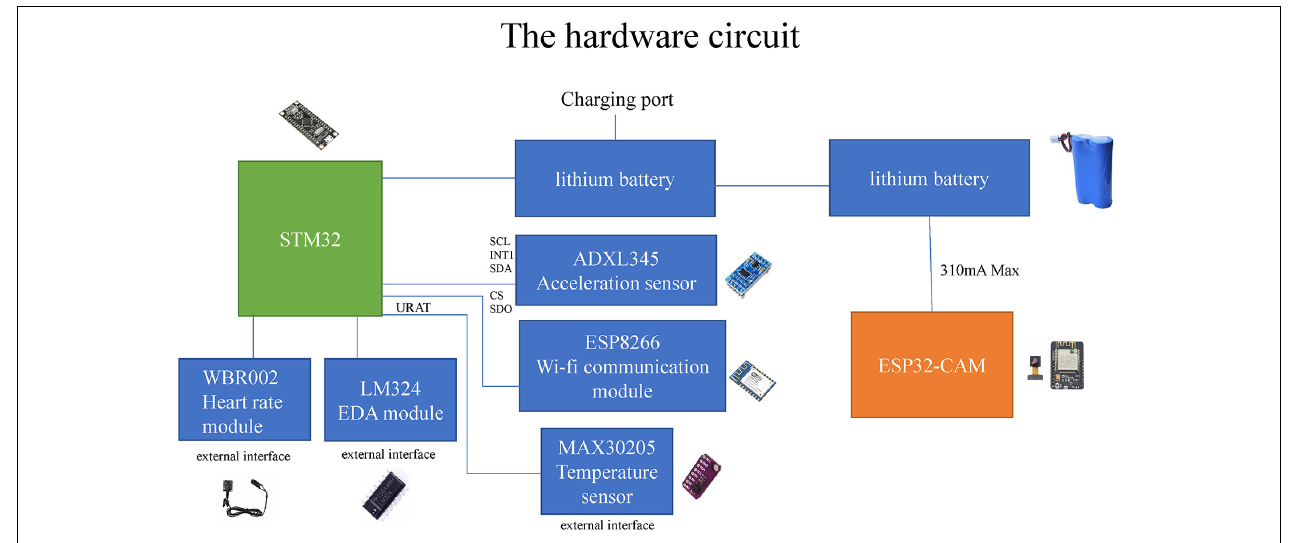
FIGURE 2 | The hardware